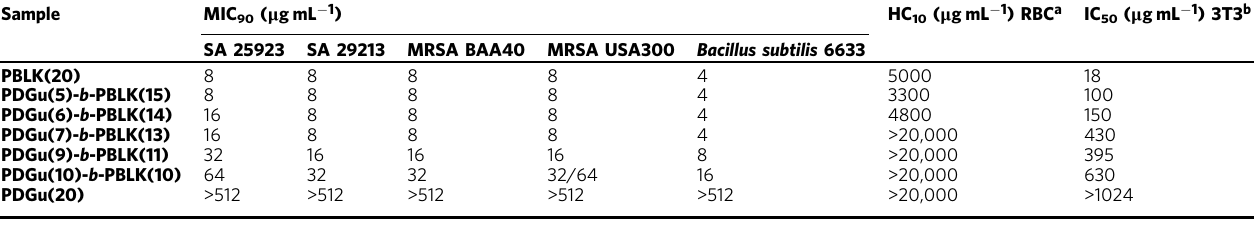
a RBC: red blood cells b 3T3: mouse fi broblast cells